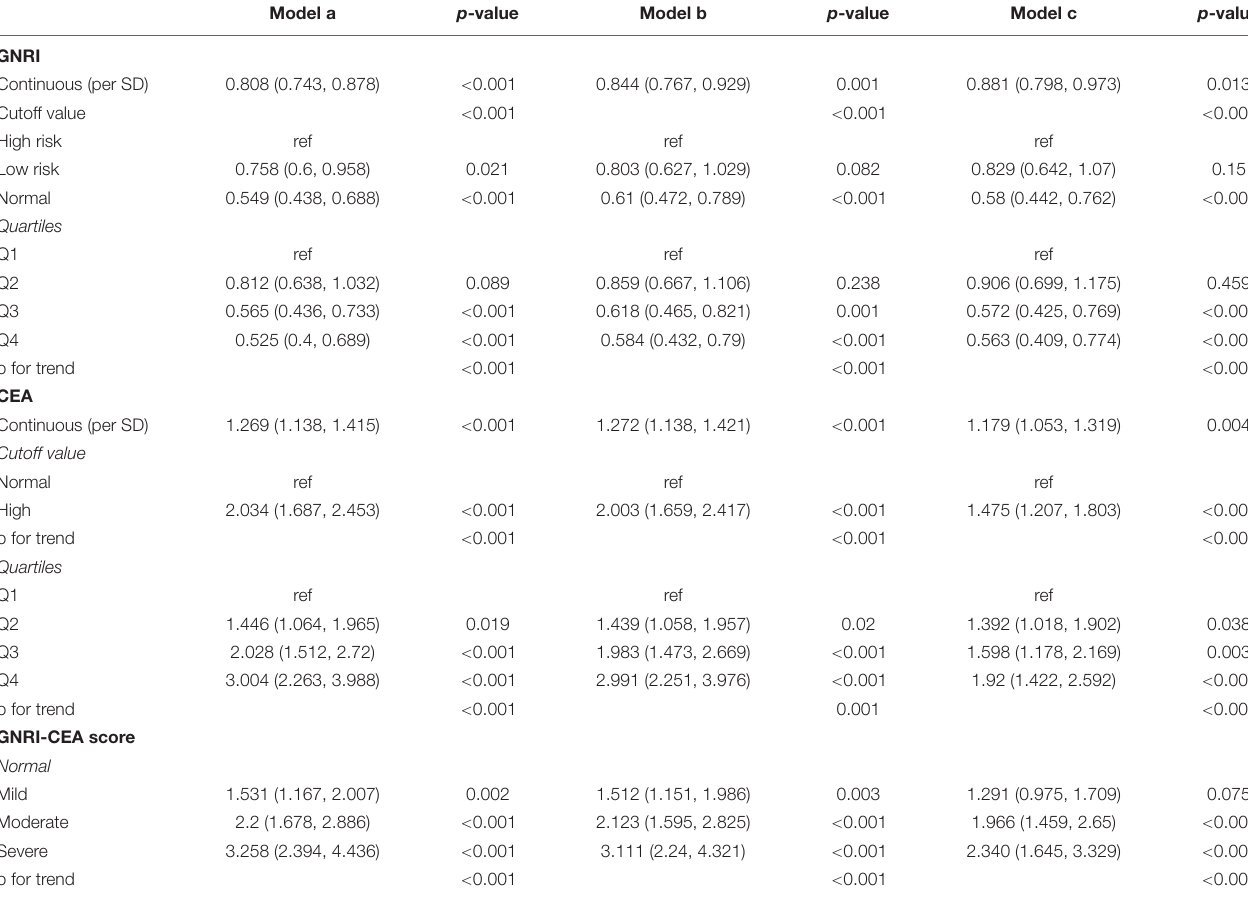
TABLE 3 | Trend test of the relationship between GNRI/CEA and overall survival. Model a p -value Model b p -value Model c